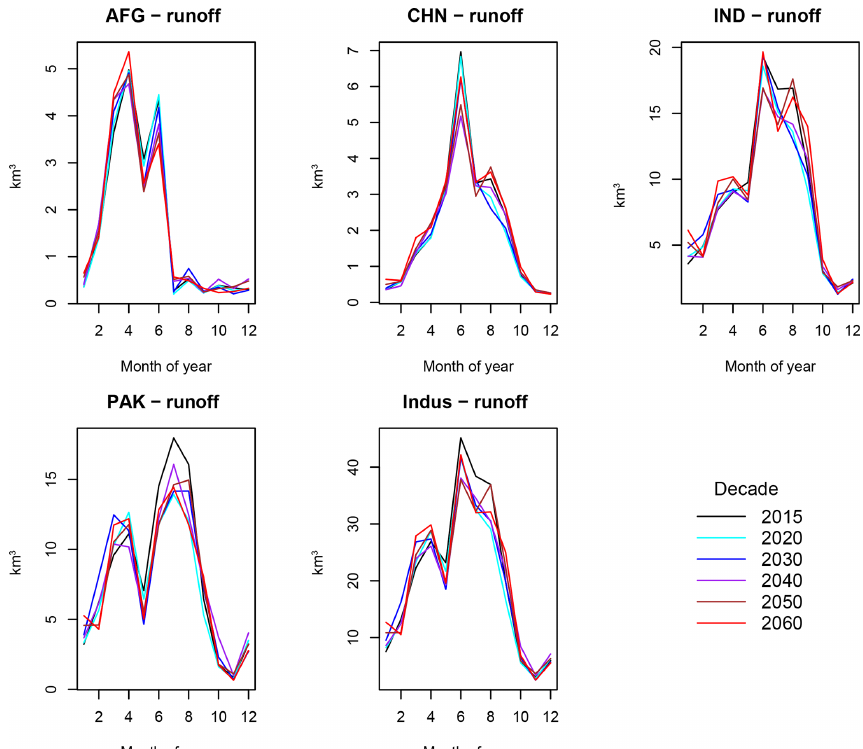
Figure 7. Ensemble mean monthly runoff in each country and the IRB as a whole. Daily runoff sequences from CWatM are converted to decadal runoff scenarios by averaging monthly gridded volumes over a 30-year time period. Outputs from four global climate models are included in the ensemble: GFDL-ESM2M, HadGEM2-ES, IPSL-CM5A-LR, MIROC5.